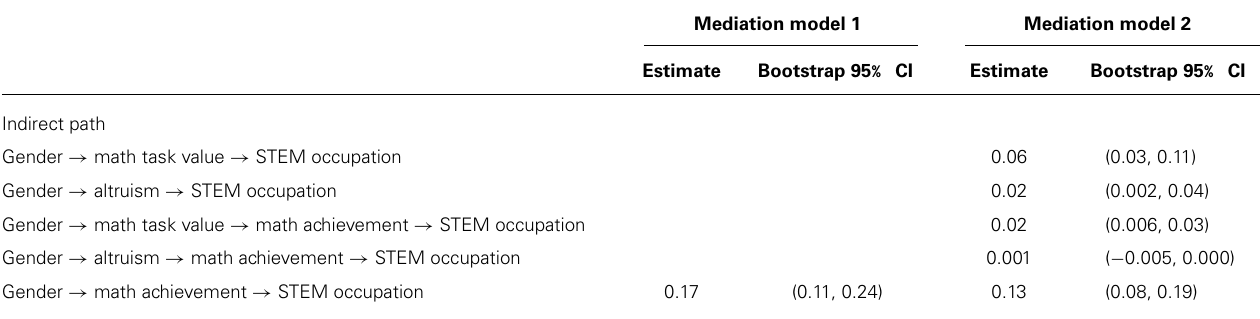
Table 3 | Mediation effect of math achievement, task value, and altruism on gender difference in STEM